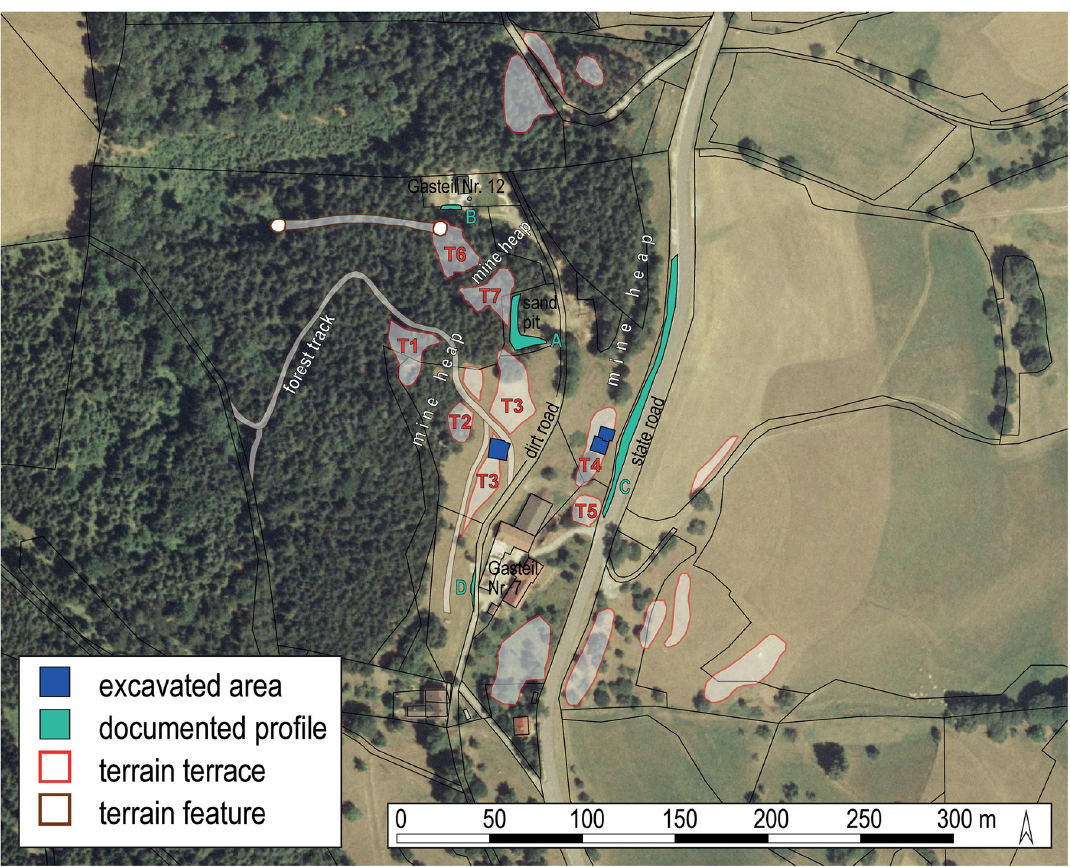
Fig 2. Prigglitz-Gasteil (Lower Austria). Plan of the Late Bronze Age site, showing visible terrain features and excavation areas on terraces T3 and T4. Aerial photograph: © Land Niedero¨sterreich, with kind permission. (Fig 4:57), one socketed chisel (Fig 4:56), one fragment of a bracelet, and one Late Neolithic hammer axe. Unfortunately, most of the artifacts from the fort were lost or are in private col- lections. There are also traces of mining activity within the region, but they have yet to be definitively dated [40]. Fifth, thirteen objects from a LBA hoard found in 1870 in the munici- pality of Ternitz at the village of Mahrersdorf (Fig 1:15) ~ 7.5 km from Prigglitz-Gasteil, were chosen for comparison to the above artifacts [21]. These objects’ chemical compositions, lead isotopic ratios, and metallographic character were studied previously [36]. The hoard contains, amongst other finds, a casting cake and a socketed pickaxe. Sixth, two hoards entirely com- posed of casting cakes found at Neunkirchen (Fig 1:16) and Heufeld near Gloggnitz (Fig 1:3) were also sampled. The hoard from Neunkirchen (11.5 km from Prigglitz) contained seven plano-convex ingots (Fig 4:68) and an irregular flat one (Fig 4:67) with a combined weight of ~ 40 kg, which, according to their shape and size, can be dated to the LBA [40]. Four of the plano-convex buns were sampled for this project. The other hoard, from Heufeld near Glogg- nitz (~ 4.5 km from Prigglitz), comprises seven small irregularly shaped flat casting cakes with a weight range between ~ 105–215 g [41]. The cakes roughly date to the Bronze Age, and four out of seven of the cakes were sampled. Seventh, from the LBA mining region of Prein an der Rax (Fig 1:1), ~ 13 km from the Prigglitz mine, two finished copper-alloy objects (one dress pin and one awl), and four ore samples found during archaeological excavations in 1952–53